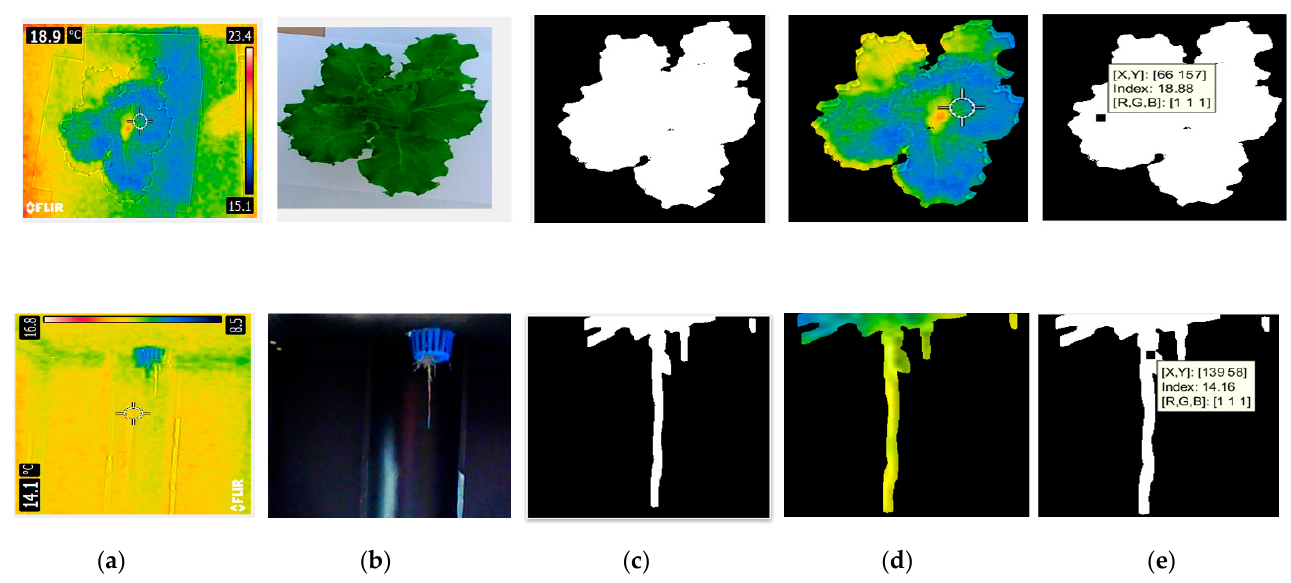
Figure 6. Leaf and root thermal image processing (FIR): ( a ) FIR image, ( b ) VIS image, ( c ) binary mask, ( d ) ROI image and ( e ) ROI image with resulting temperature.